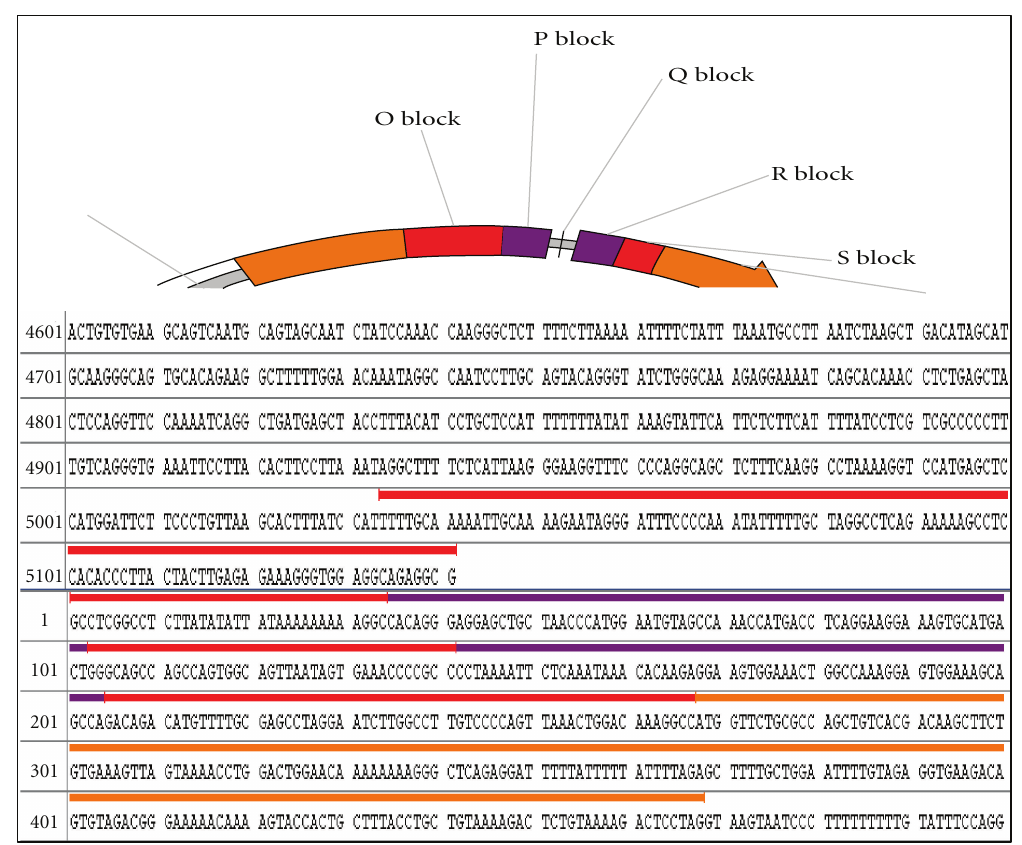
Figure 2: Diagram showing the noncontrol coding region (NCCR) region and describing the nucleotide sequence of the O, P, Q, R, and S blocks in di ff erent